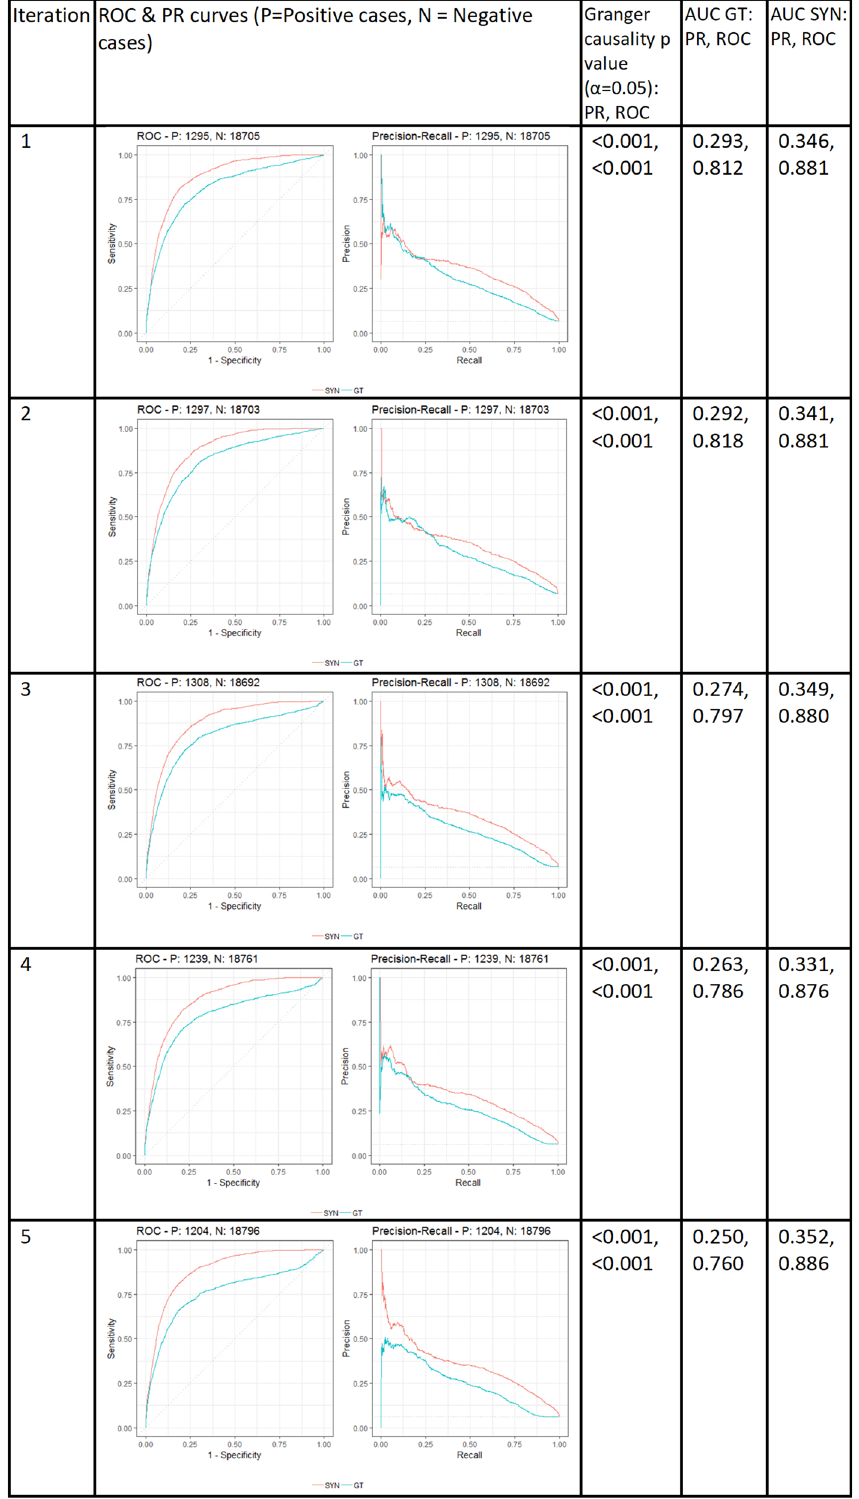
Fig. 4 Five-sample sensitivity analyses for a Bayesian generalised linear classi fi er on GT and SYN data (latent model) for fi xed sample size of 100,000, including ROC and PR curves, and AUC and Granger